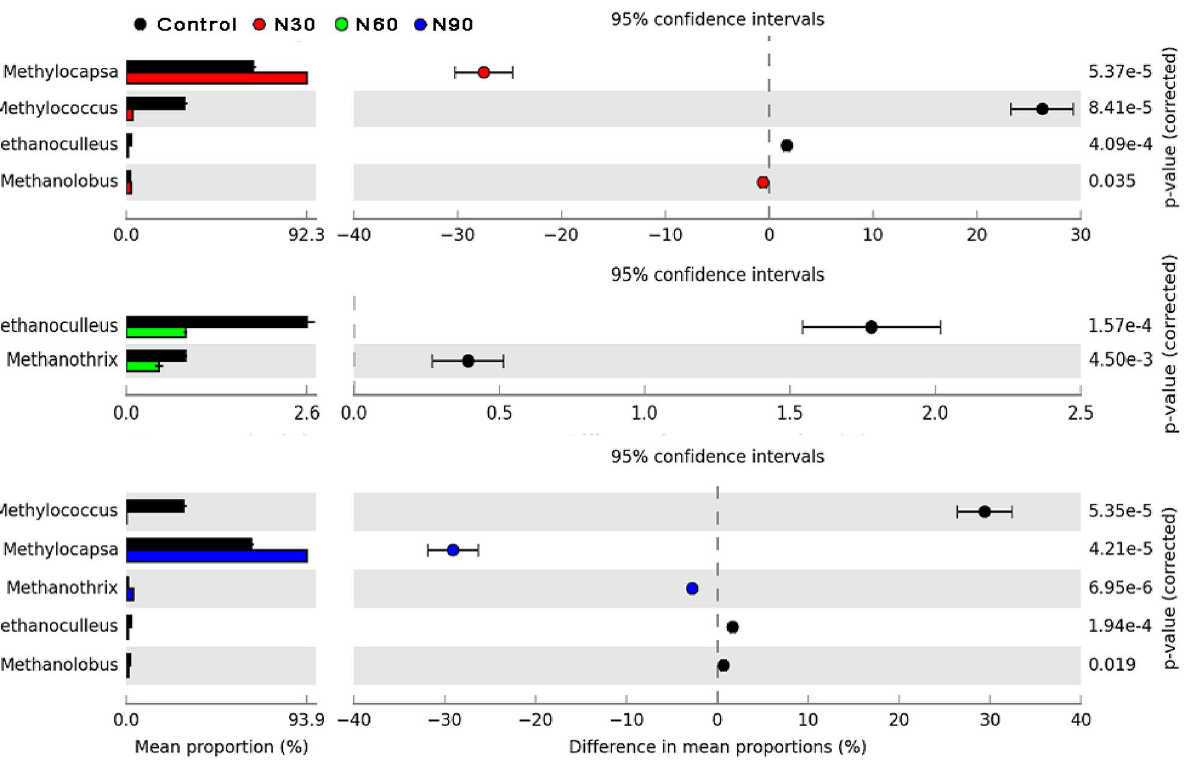
Figure 5. Dominant methanotrophs ( pmoA ) and methanogens ( mcrA ) under N addition